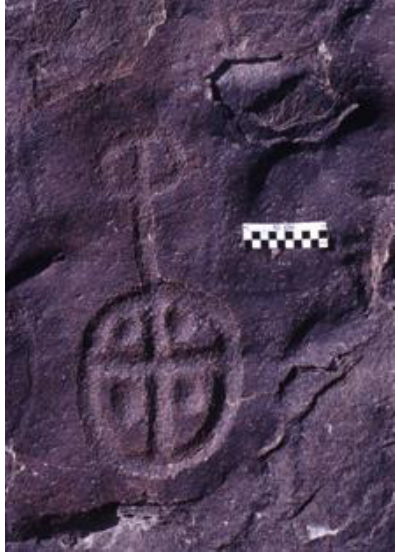
Figure 16. Early petroglyphs at Helanshan, Ningxia Hui, but of the Holocene.